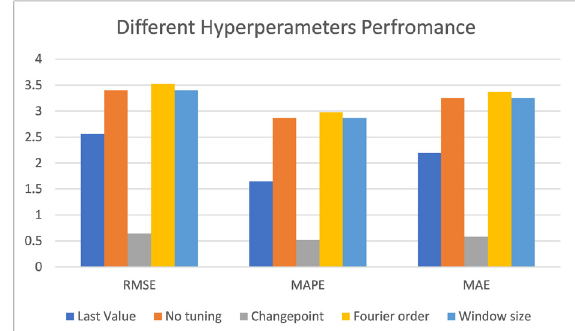
Figure 4. Performance Bar Graph